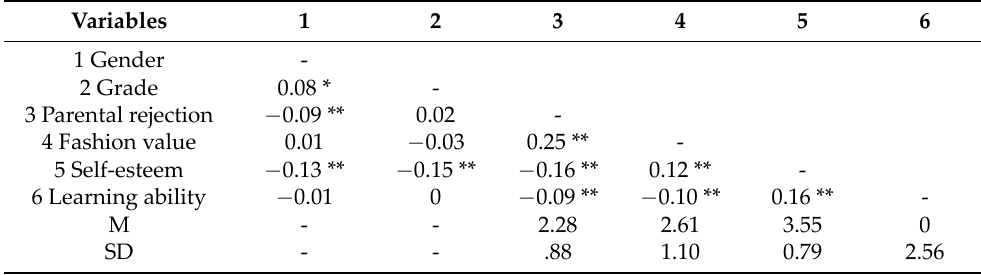
Table 1. Means, standard deviations and correlation between the